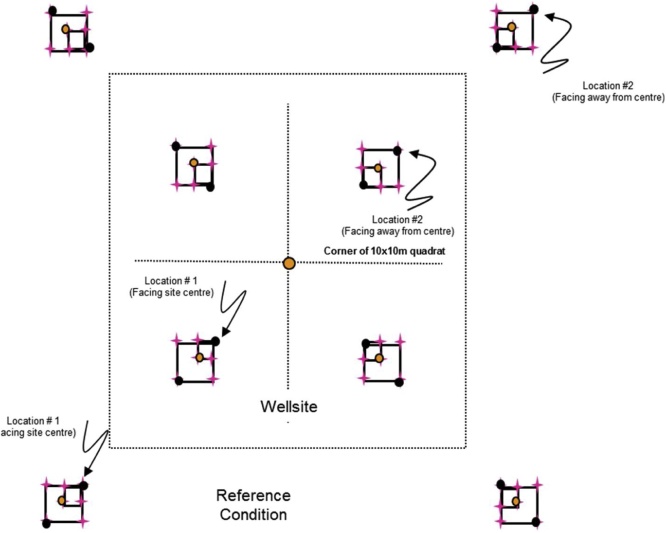
Location of points where canopy cover is measured.Black dots show measurement points.